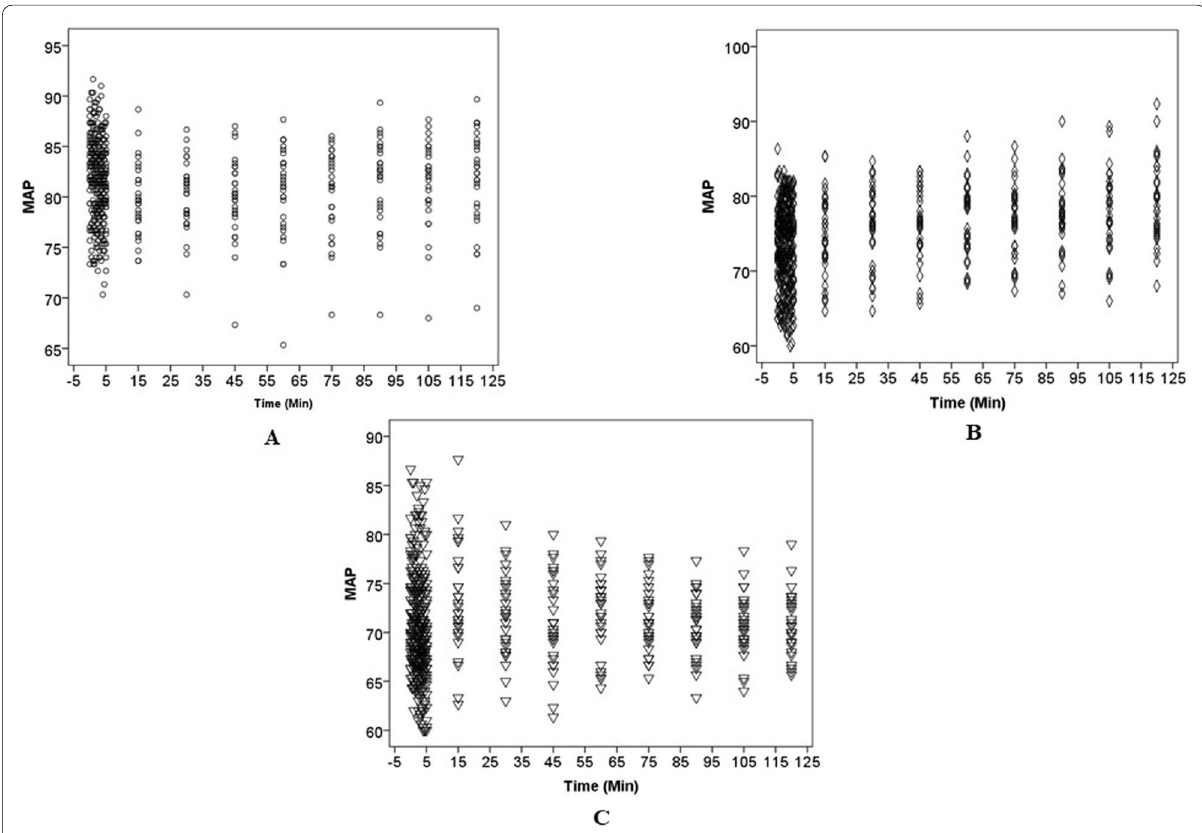
Fig. 3 Graph showing trends of MAP in post-extubation